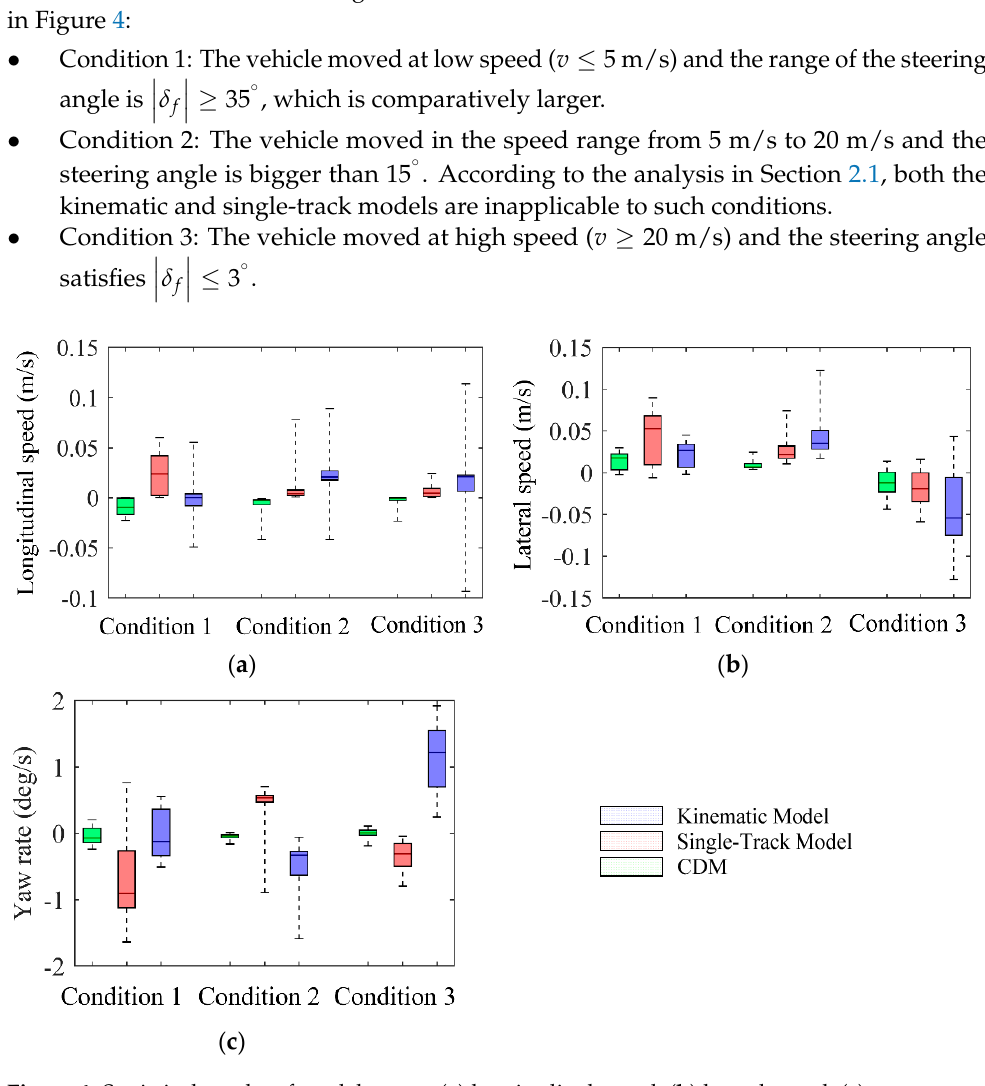
Figure 4. Statistical results of model errors: ( a ) longitudinal speed; ( b ) lateral speed; ( c ) yaw rate.